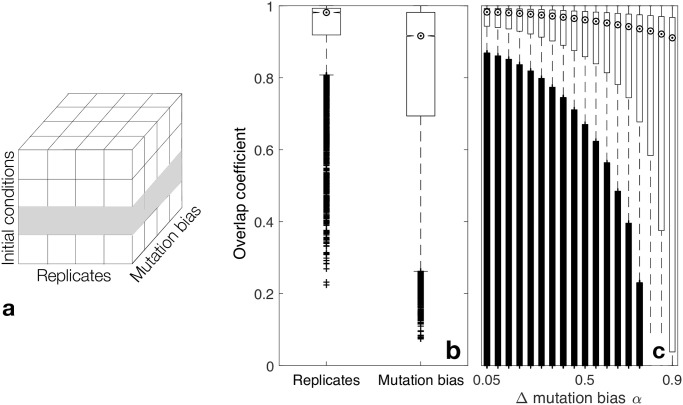
Evolving polymorphic populations are more sensitive to changes in mutation bias than to the stochastic nature of the evolutionary simulations.(a) Schematic figure of our experimental design. For each landscape and combination of population size and mutation rate (Nμ), we considered 10 replicates for each of 10 different initial conditions and 19 values of the mutation bias parameter α. Importantly, we used the replicate number to seed the random number generator of each evolutionary simulation, facilitating the comparison of variation across replicates versus across the mutation bias parameter α. For example, the matrix elements indicated in gray contain the information necessary to compare the effects of the mutation bias parameter with the stochasticity of the evolutionary simulations, for one initial condition. (b) Overlap coefficient for pairs of evolved populations that differ in random number generator seed (“Replicates”) or in mutation bias parameter (“Mutation bias”). Notches indicate medians, whiskers indicate the 25th and 75th percentiles, and cross symbols indicate outliers. (c) Overlap coefficient for pairs of evolved populations, shown in relation to the difference in their mutation bias parameters.